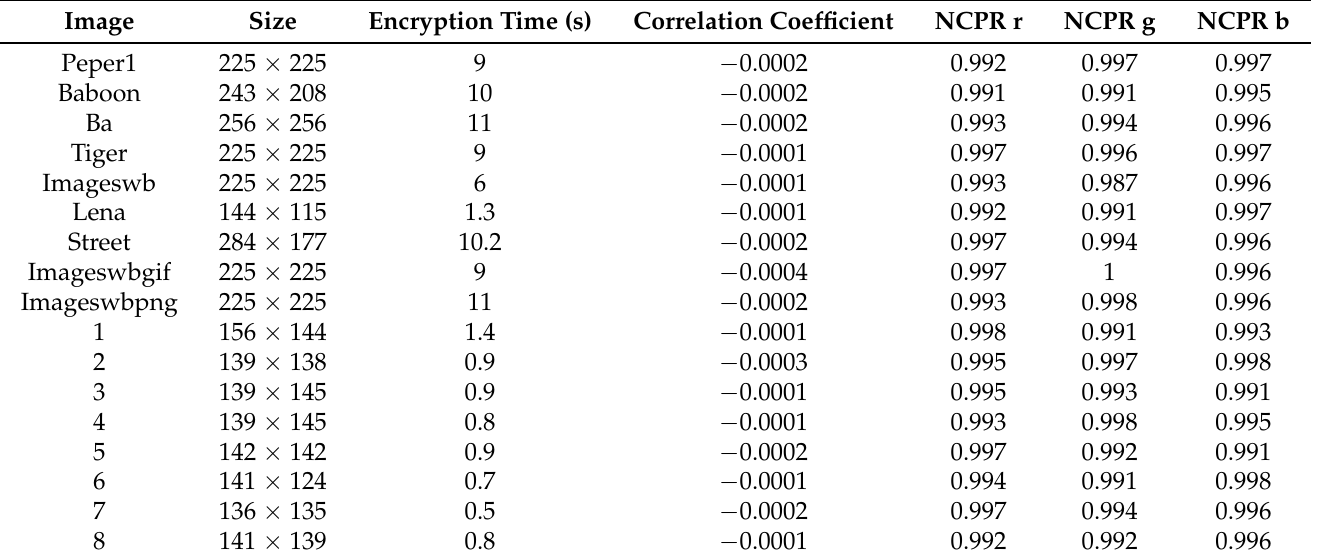
Table 3. Time consumption for the encryption, decryption process, correlation coefficient ratio be- tween plain images and their corresponding cipher images, and NPCR of different color components.